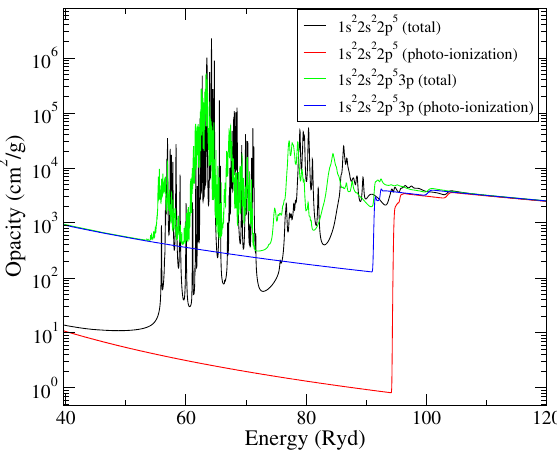
Figure 18. Total and photo-ionization opacities of configurations 1 s 2 2 s 2 2 p 5 and 1 s 2 2 s 2 2 p 5 3 p (SCO-RCG